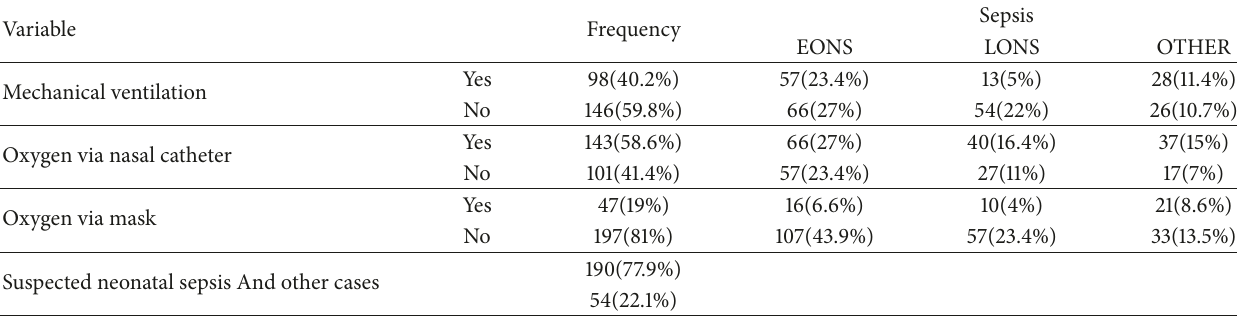
Table 4: Medical risk factors for neonatal sepsis among neonates admitted in Shashemenne referral hospital and Melka Oda district hospital in NICU wards, Ethiopia,